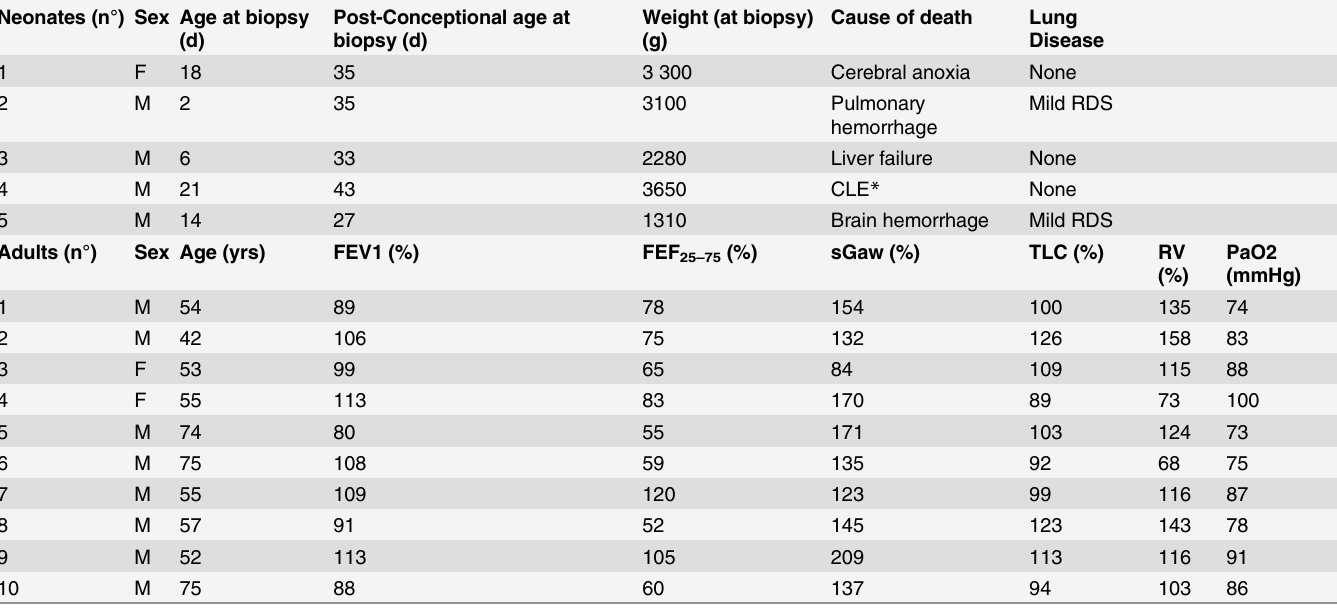
Table 1. Patients ’ characteristics. Neonates (n°) Sex Age at biopsy